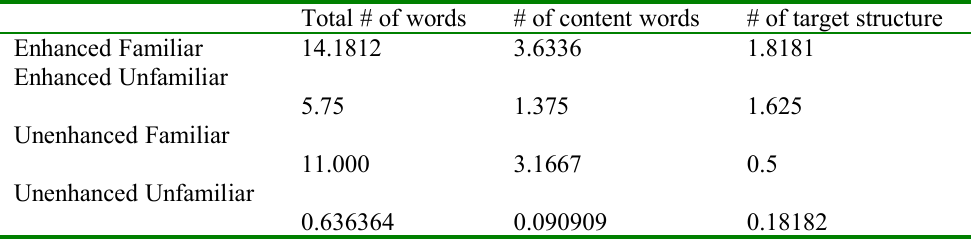
Written Recall Frequency